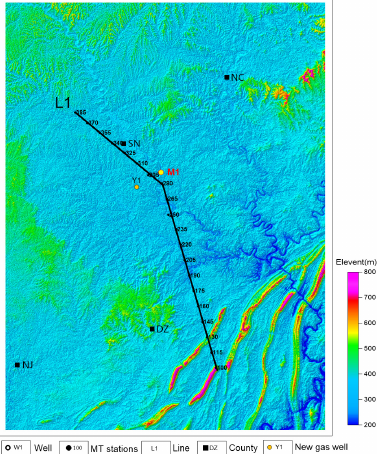
Figure 12. Location of survey line in the study area.